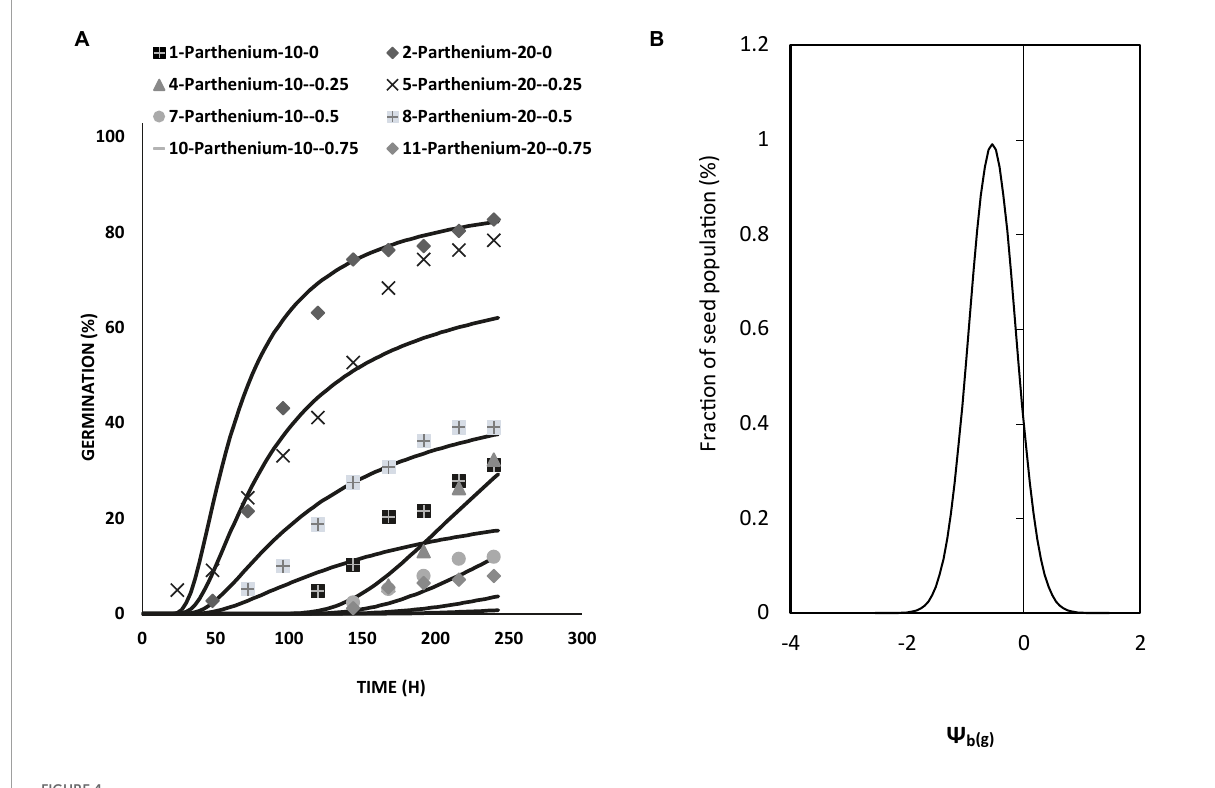
FIGURE4 (A) Germination curve of Parthenium hysterophorus at different levels of water potential and temperatures by using the hydrothermal time model under controlled environment (lab condition). (B) Model distribution for germination of parthenium seeds showing different frequencies of (cid:57) b ( g ) at different levels of water potentials and temperatures by using the hydrothermal time model under controlled environment (lab